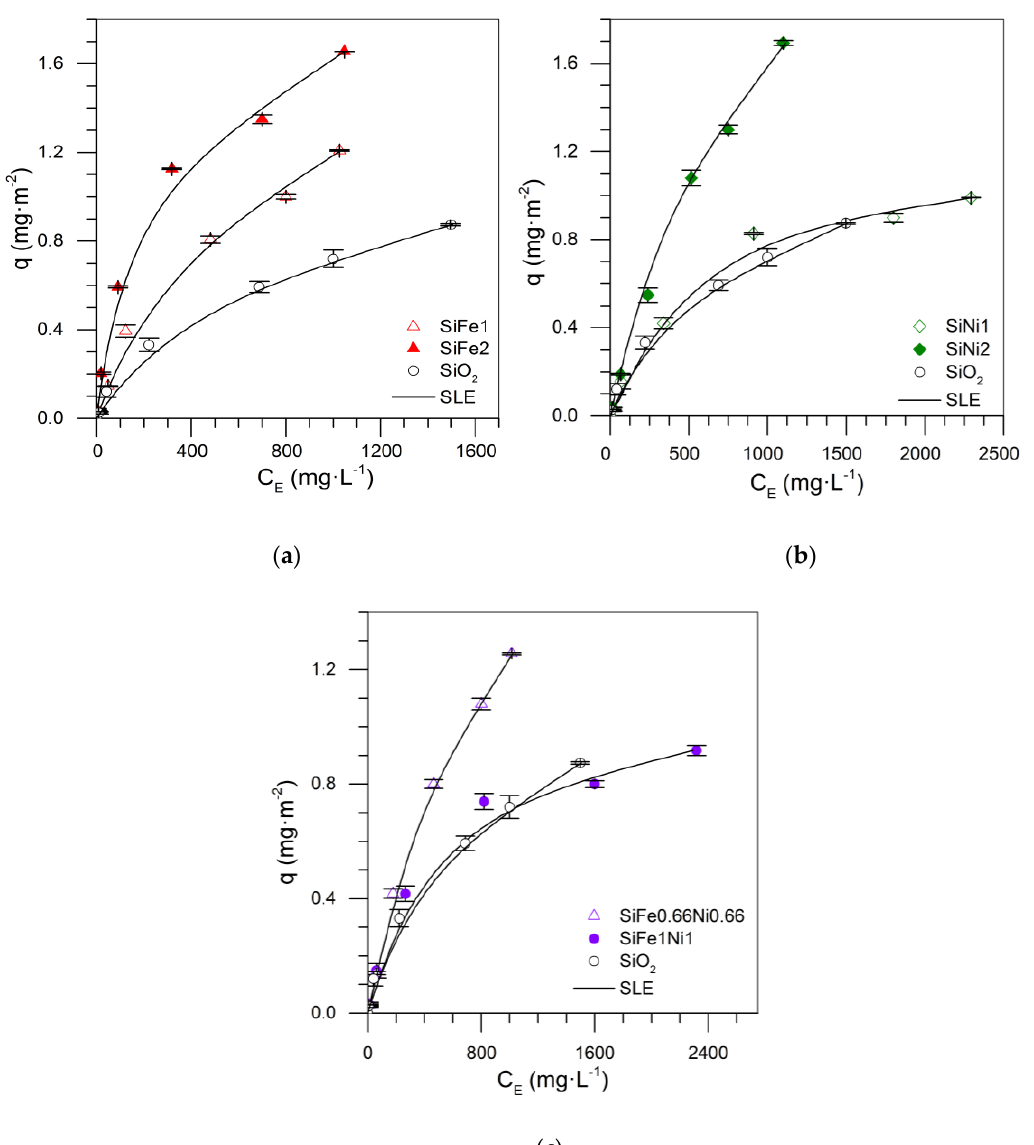
Figure 3. Asphaltene adsorption isotherms for nanoparticles ( a ) SiO 2 , SiFe1, SiFe2, ( b ) SiO 2 , SiNi1, SiNi2, and ( c ) Si, SiFe1Ni1, SiFe0.66Ni0.66 at 25 ◦ C. The symbols are experimental data, and the solid lines are from the SLE model.